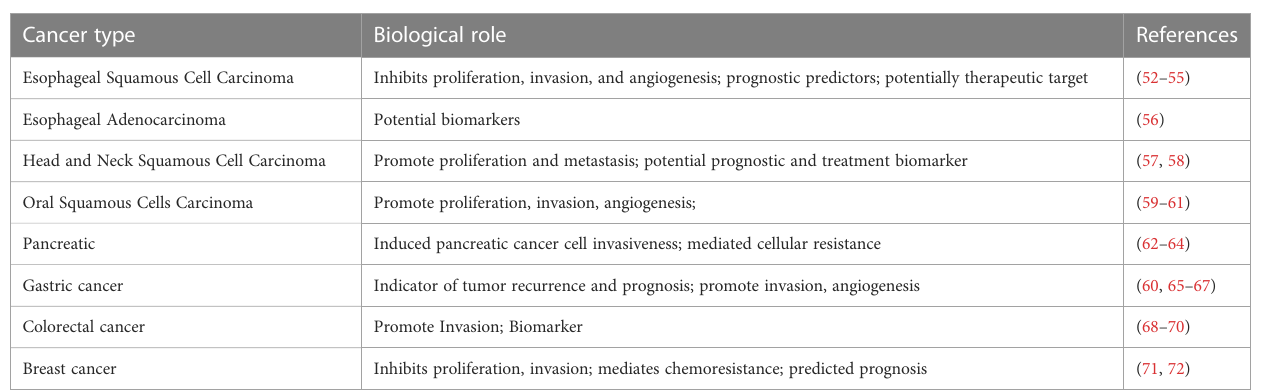
TABLE 1 The biological roles of CD147 in different